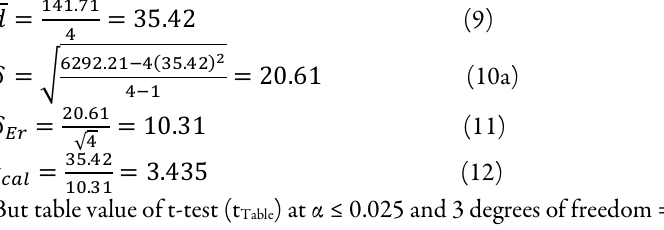
But table value of t-test (t Table ) at α ≤ 0.025 and 3 degrees of freedom = 3.182 Similarly, the calculated value of paired t-test (t cal ) for the growth rate =